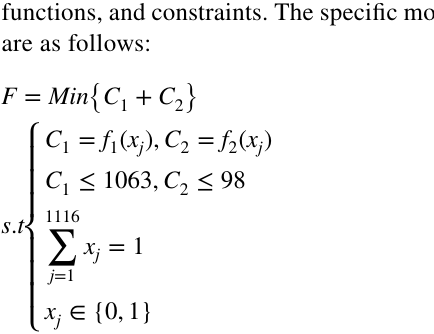
Fig. 5 Location of cutoff